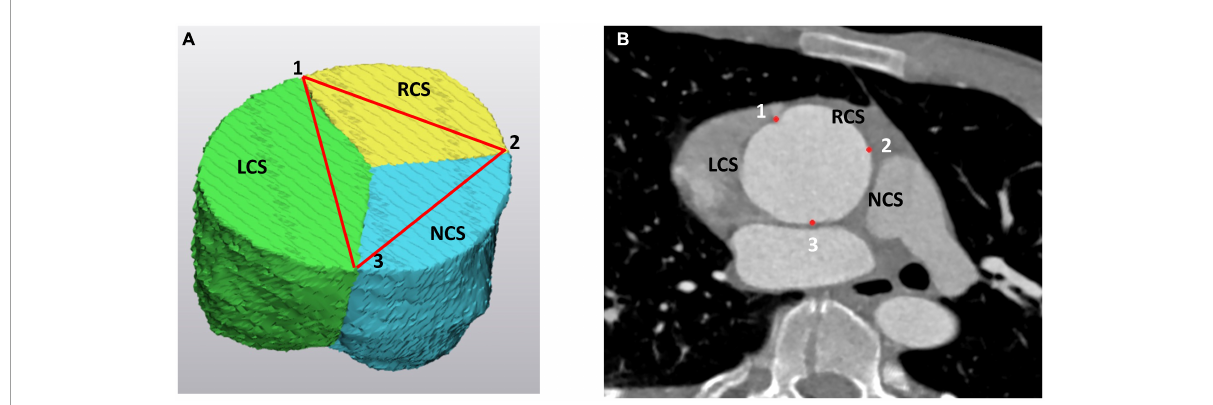
FIGURE2 The three commissures at the level of the sinotubular junction (STJ) as (A) on the 3D model of the aortic root and (B) on the angio CT scan. The “ 123 ” landmarks correspond to the left (LCS), right (RCS), and non (NCS) coronary sinus commissures. On the 3D model the LCS is marked as green, the RCS is yellow and the NCS is blue. LCS, left coronary sinus; RCS, right coronary sinus; NCS, non-coronary sinus.